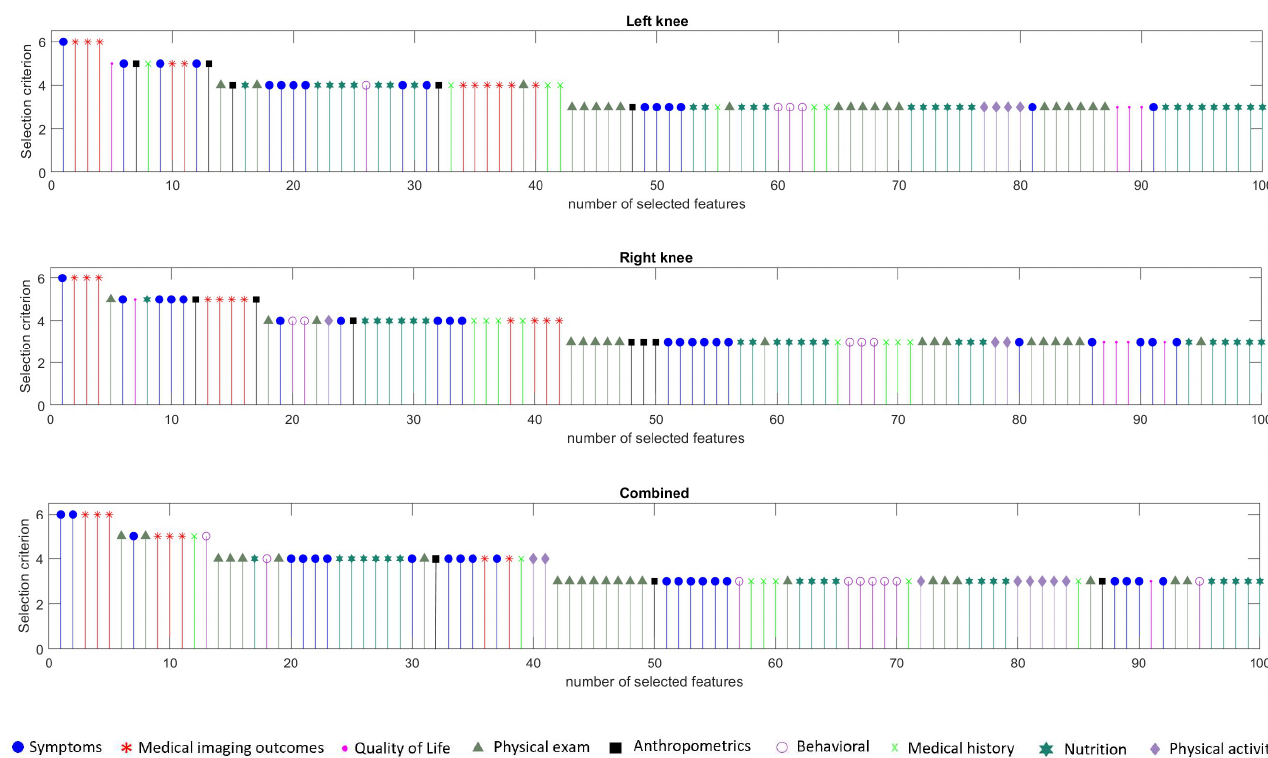
Figure 4. The first 100 features selected for the left ( top ), the right knee ( middle ), and both legs ( down ).